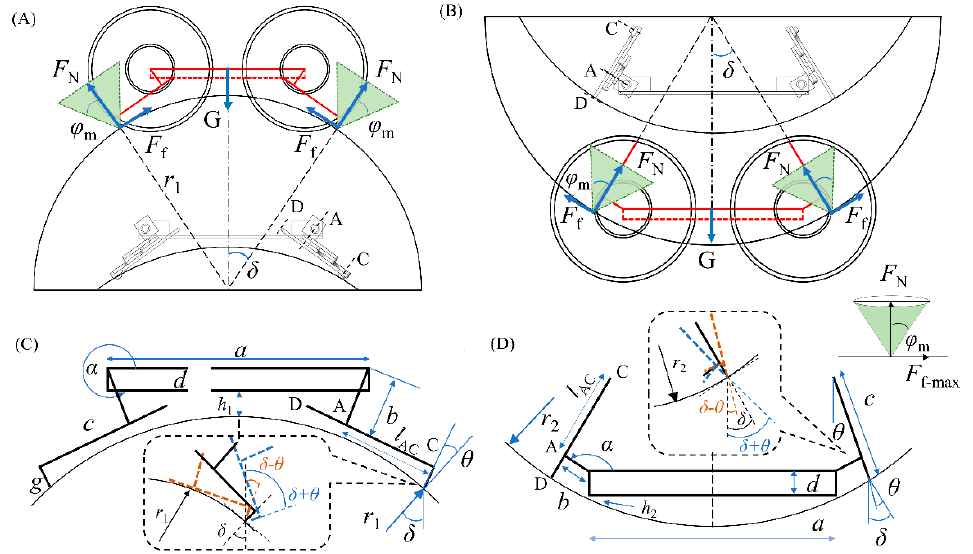
Figure 5. The robot moves on the inner and outer surfaces of the arc (the arc radius is r 1 , and the friction angle is φ m ; the support position and the support posture of the leg are represented by angles δ and θ , respectively). ( A ) The robot moves on the outer surface of the arc in a creeping posture; ( B ) the robot moves on the inner surface of the arc with the configuration supported by point D; ( C ) the meaning of the geometric dimensions that need to be considered when moving on the outer surface; ( D ) the meaning of the geometric dimensions that need to be considered when moving on the inner surface.